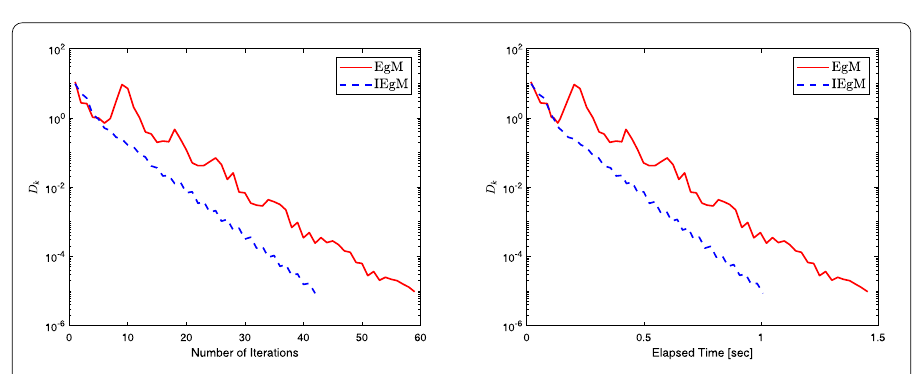
Figure 9 Computational comparability of Algorithm 2 with Algorithm 3.1 in [36] for M = 100